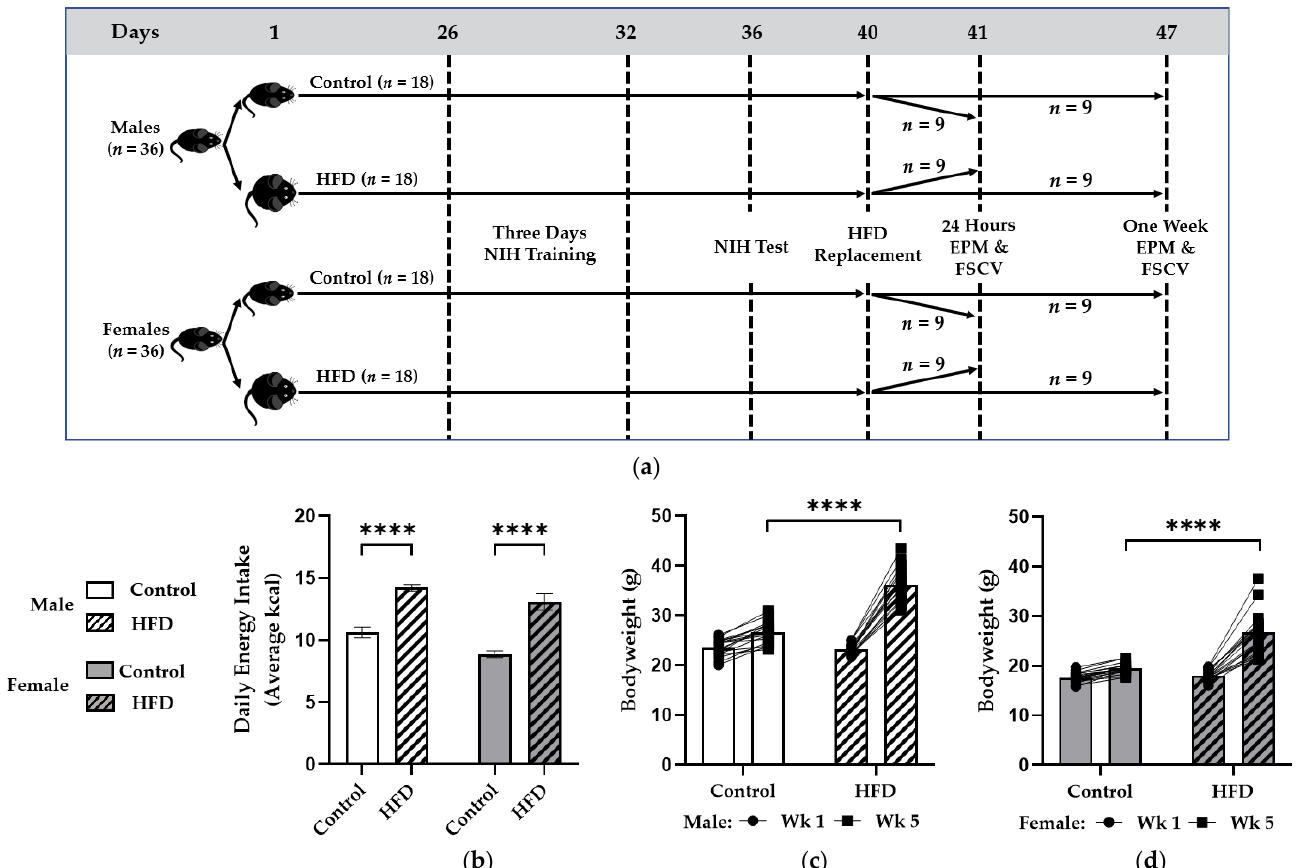
Figure 1. Experimental Design, Food Intake, and Bodyweight. ( a ) Male and female C57BL/6J mice were placed on a control 10% fat diet (Control) or high saturated 60% fat diet (HFD) for six weeks. During ad libitum feeding, the novelty-induced hypophagia (NIH) paradigm was completed. Subsequently, the HFD replacement paradigm was started and continued for one day or one week, followed by the elevated plus-maze (EPM) then ex vivo slice fast-scan cyclic voltammetry (FSCV) immediately afterwards. Average daily kcal intake ( b ) is shown for all groups in addition to bodyweight in grams at weeks one (Wk 1) and five (Wk 5) of feeding for males ( c ) and females ( d ). Bodyweight data are displayed individually for each mouse. * denotes a significant difference between diet groups. ****, p < 0.0001.